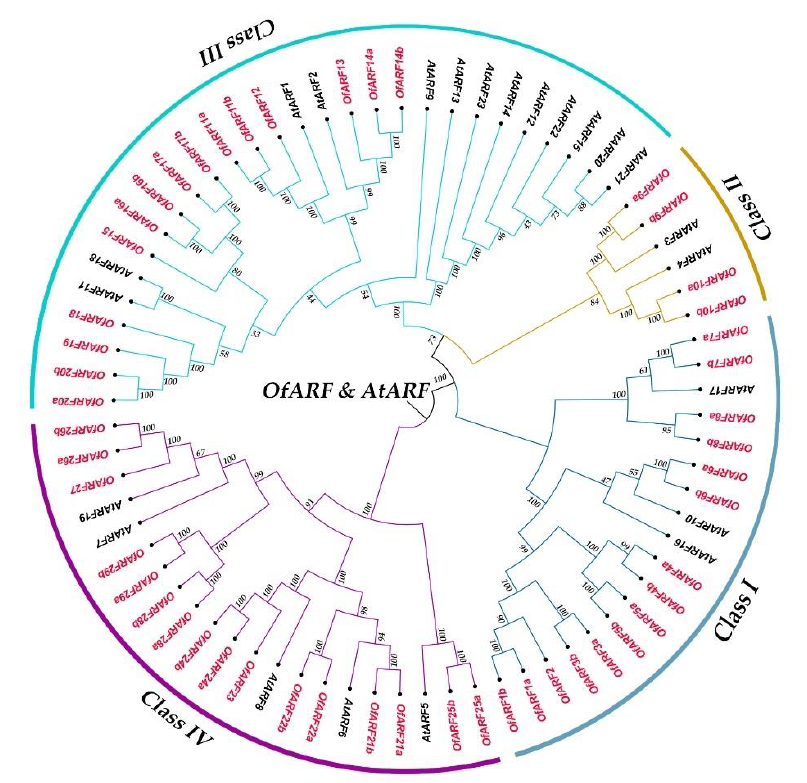
Figure 1. Phylogenetic relationship of 50 Osmanthus fragrans auxin response factors ( OfARF s) and 23 Arabidopsis thaliana auxin response factors (AtARF s) .